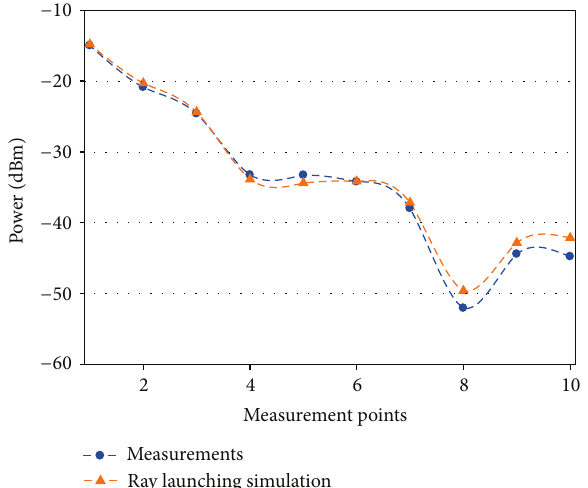
Figure5: Comparisonof simulationversusmeasurements forboxes 10 to 1 in the pallet.